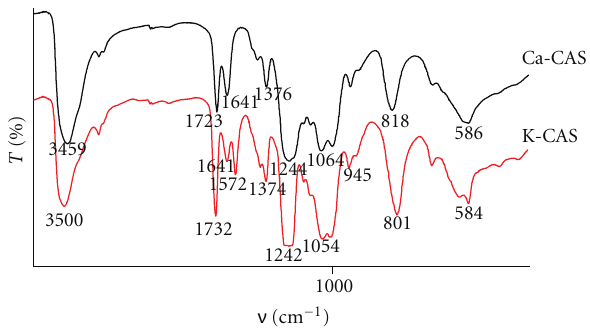
Figure 9: IR spectra of K- and Ca-CAS.